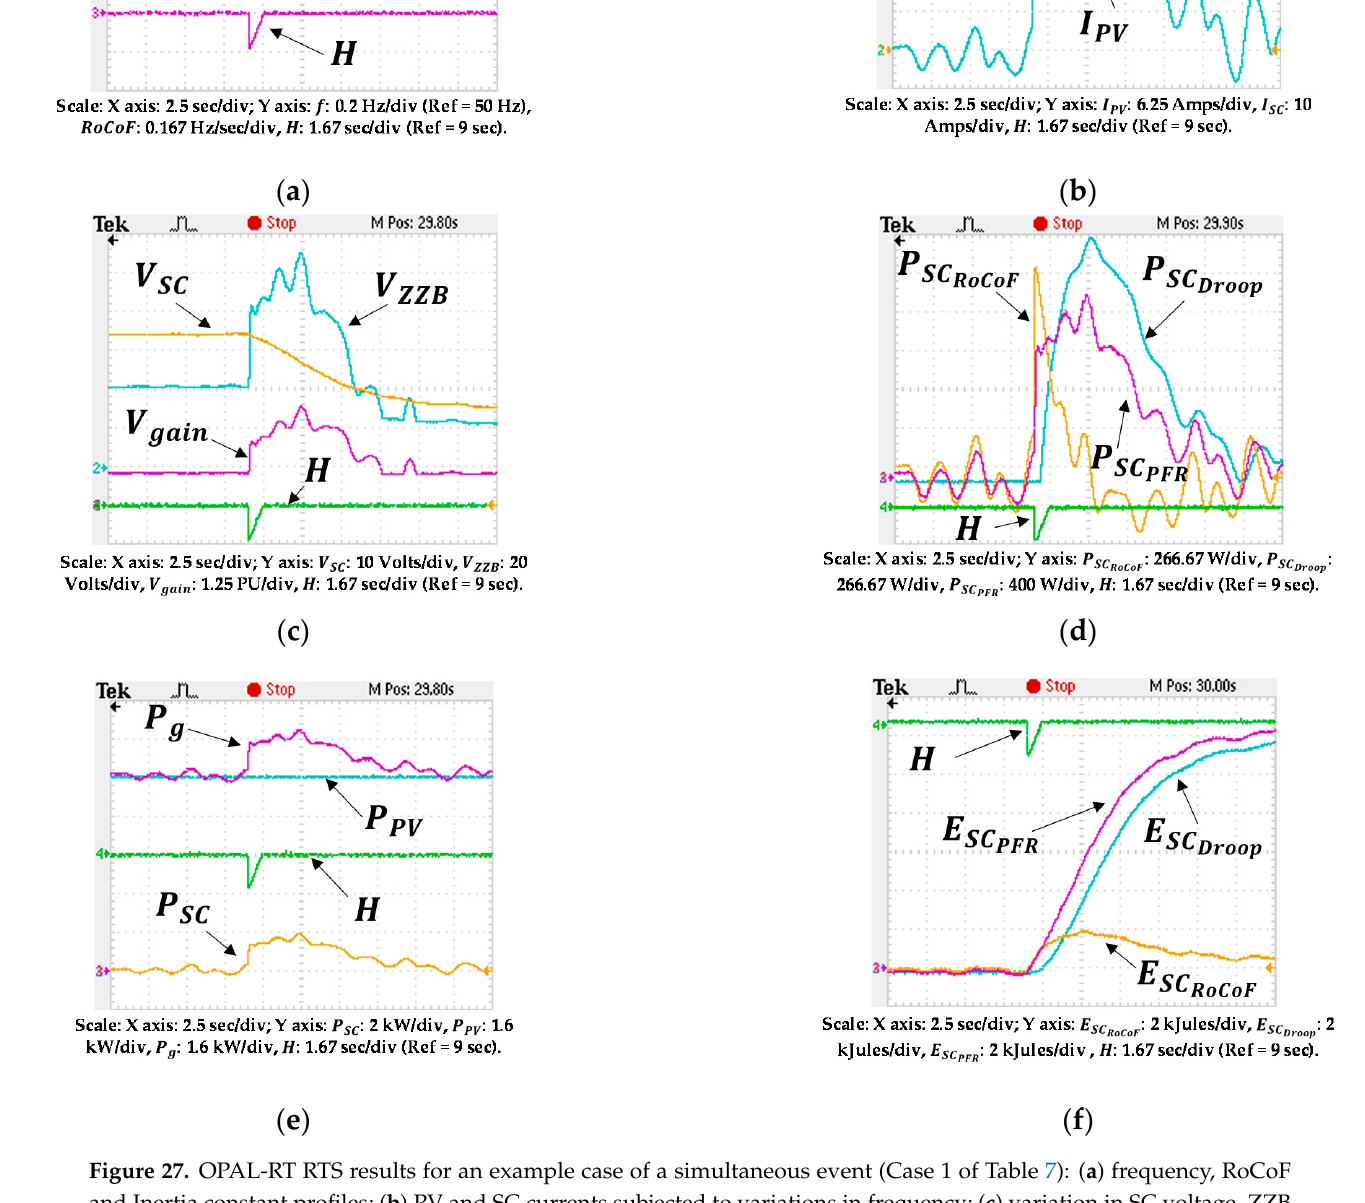
Figure 27. OPAL-RT RTS results for an example case of a simultaneous event (Case 1 of Table 7): ( a ) frequency, RoCoF and Inertia constant profiles; ( b ) PV and SC currents subjected to variations in frequency; ( c ) variation in SC voltage, ZZB voltage and the Voltage gain of ZZB; ( d ) power profiles for the SC corresponding to RoCoF, Droop and PFR; ( e ) PV, SC and grid power profiles; ( f ) energy profiles for the SC corresponding to RoCoF, Droop and PFR.